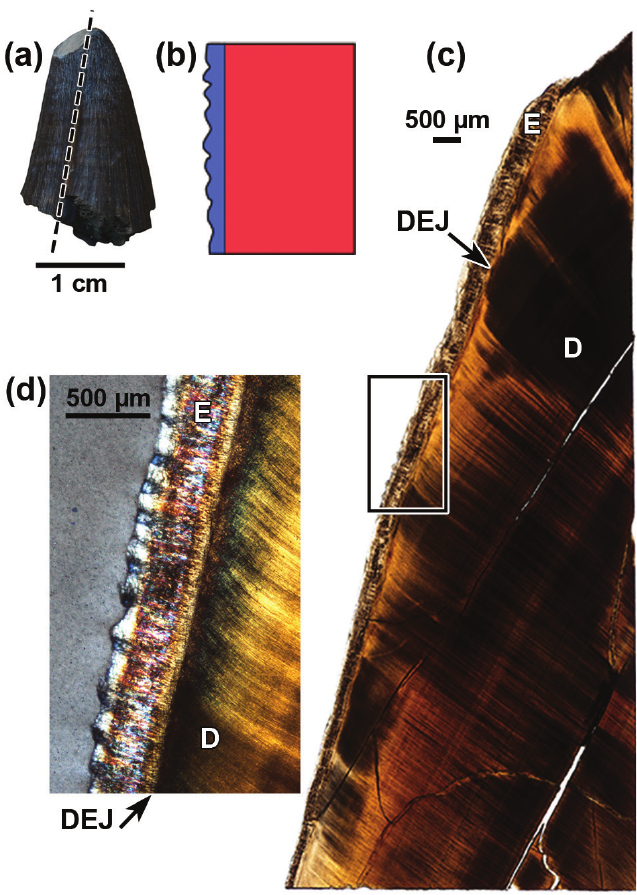
Figure 5. Anatomy of the false denticulations on a carina on a Prognathodon sp. tooth (TMP 86.036.0463). A, tooth in posterior view with approximate plane of section indicated by the dashed line; B, schematic diagram illustrating the relationship between the enamel (blue) and the dentine (red); C, longitudinal section seen under plane polarized light. Box indicates the region magnified in (D). D, close-up of the dentine-enamel junction viewed under crossed polar- ized light. Abbreviations: D, dentine; DEJ, dentine-enamel junction; E,